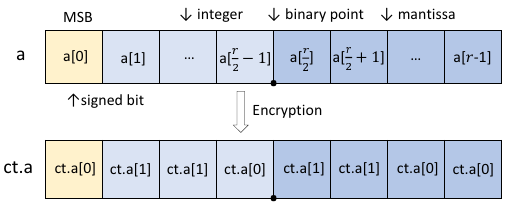
Figure 1. Fixed point representation of 8-bit real number.